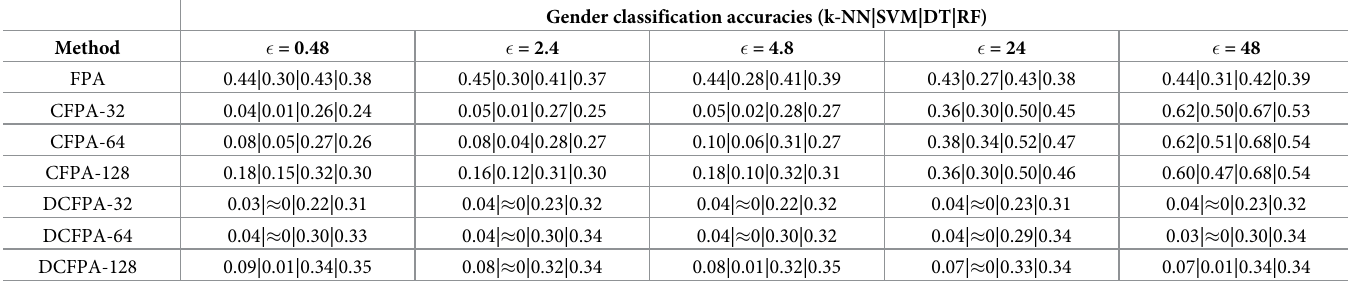
Table 2. Gender classification accuracies in the MPIIDPEye dataset using differentially private eye movement features with majority voting.